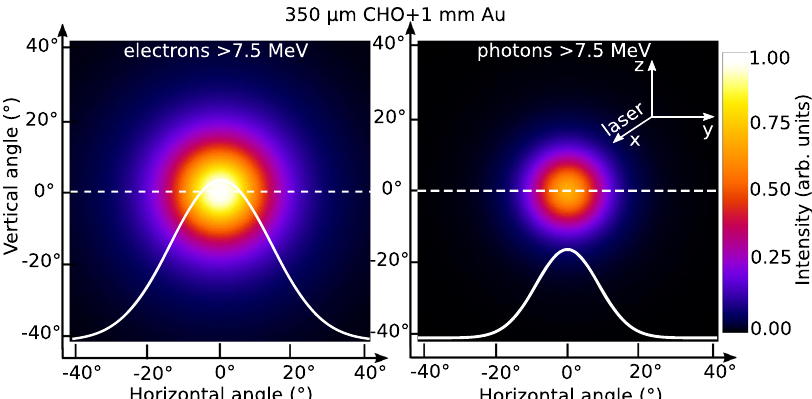
Fig. 4 Simulated angular distribution. GEANT4 simulations of the angular distribution of electrons and photons above 7.5 MeV after the laser pulse interaction with an aerogel-foam (CHO) target combined with a 1 mm thick converter (Au). The angular distributions are shown using the same color scale in arbitrary unit. The half divergence angle of the electron beam is 17 ∘ , where the photons are distributed within the half divergence angle of 10.5 ∘ . The white curves represent the line-out (dashed lines) of the colored distribution in the range of the horizontal angle in degree ( ∘